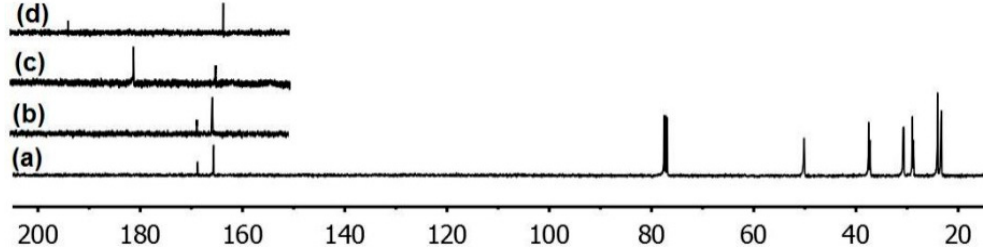
13 C–NMR spectra of derivatives of modifier 6 : ( a ) TCTA-Cl; ( b ) TCTA-thiouronium salt; ( c ) TCTA-SH and ( d ) TCTA-SNa is 165.6 ppm. Similarly, the C–S shift of the thiouronium salt.